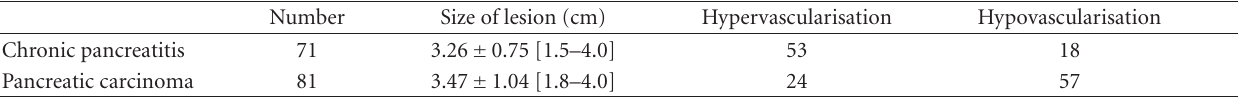
Table 1: Discrimination of pancreatic lesions using contrast enhancement patterns in patients with chronic pancreatitis